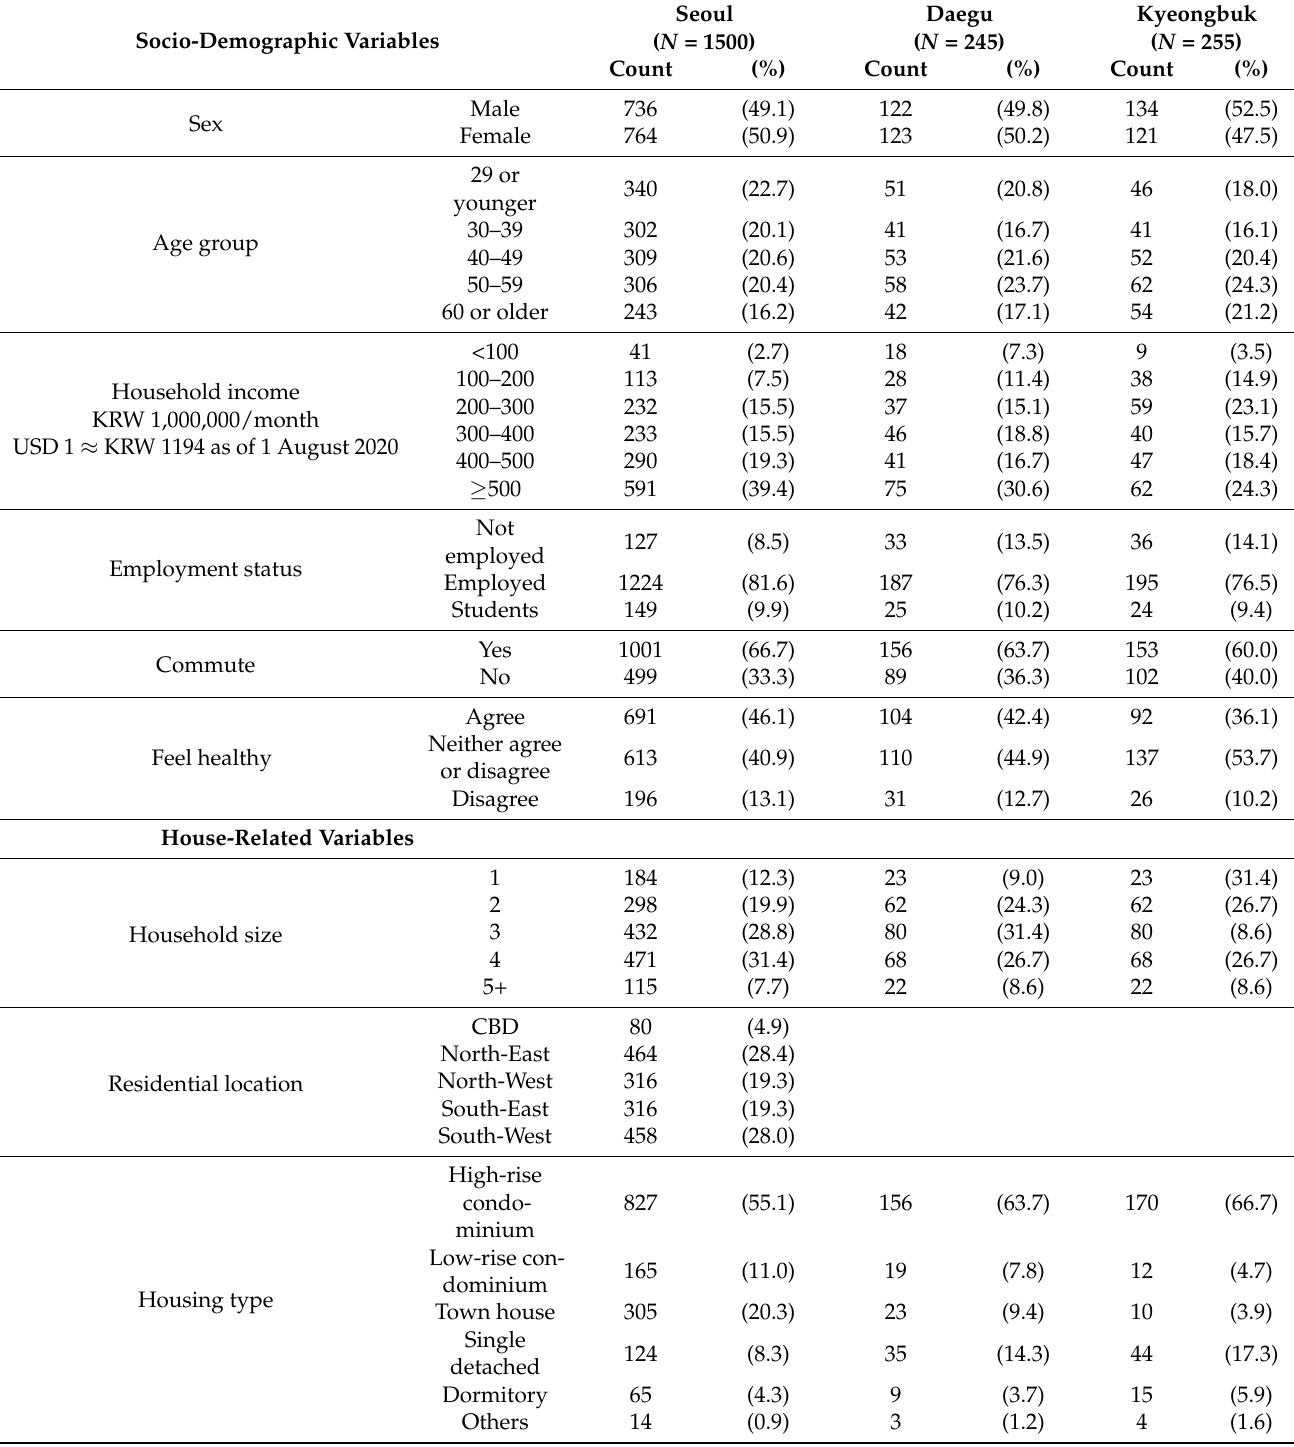
Table 2. Sample descriptive